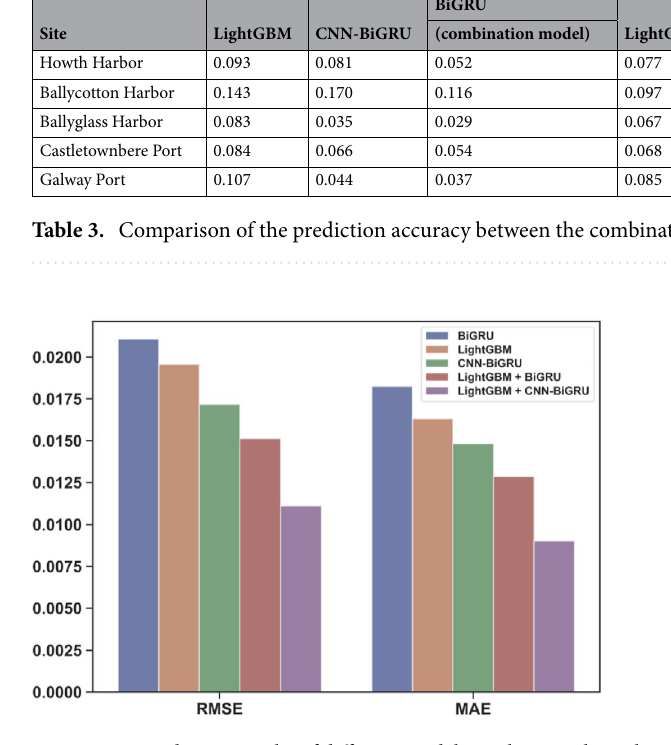
Figure 12. Prediction results of different models on the Howth Harbor